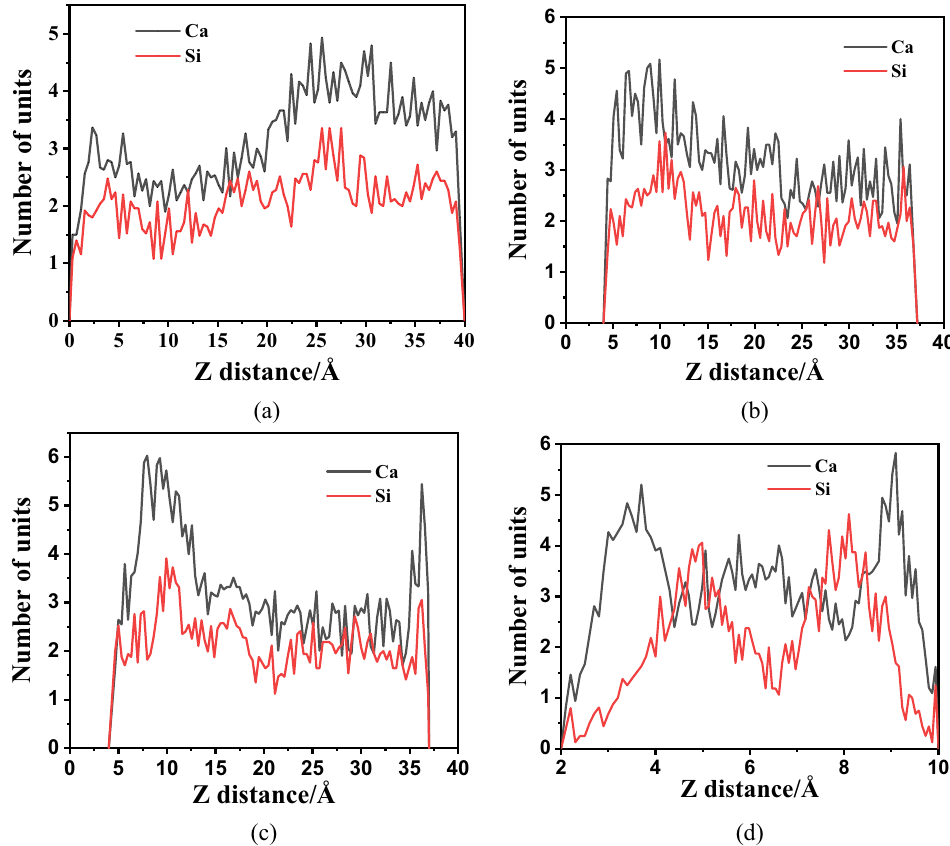
Figure 8: Distribution of Ca and Si atoms in z direction. ( a ) Control, ( b ) GCOOH40 - 25, ( c ) GCOOH40 - 50, and ( d ) GCOOH10 -